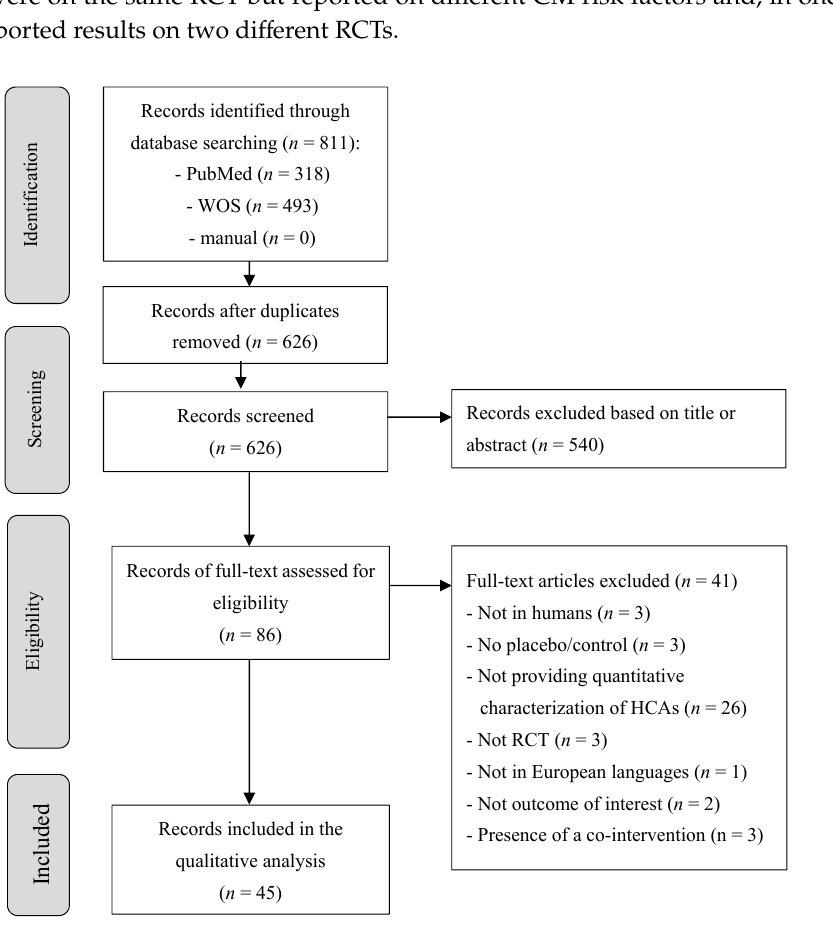
Figure 1. Flowchart of the study selection process. Legend: HCAs: Hydroxycinnamic acids; RCT: Randomized controlled trial and WOS: Web of